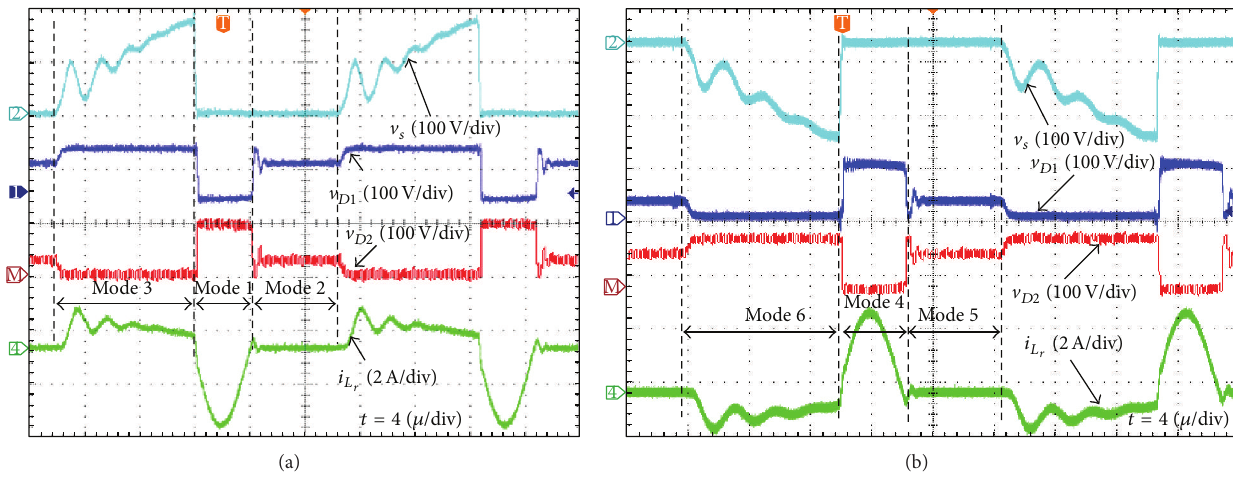
Figure 10: The key operation waveforms of the converter (a) with positive input voltage and (b) with negative input voltage.